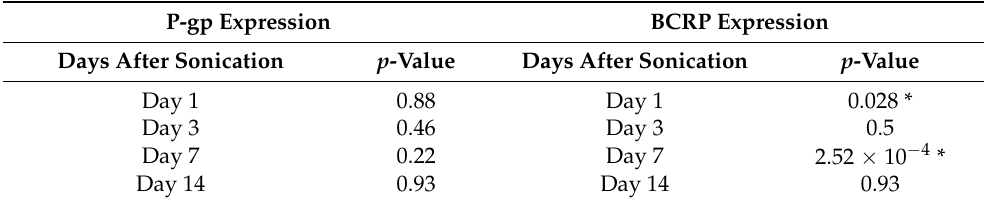
Table 1. The p -values resulting from the Mann–Whitney tests performed to compare P-gp and BCRP expression between the sonicated and contralateral brain regions at 1, 3, 7, and 14 days after FUS application (18 ROIs per brain hemisphere, at each time point). The p -values were corrected for multiple comparisons (fdr, alpha = 0.05). Corrected p-values less than 0.05 are flagged with one star (*).